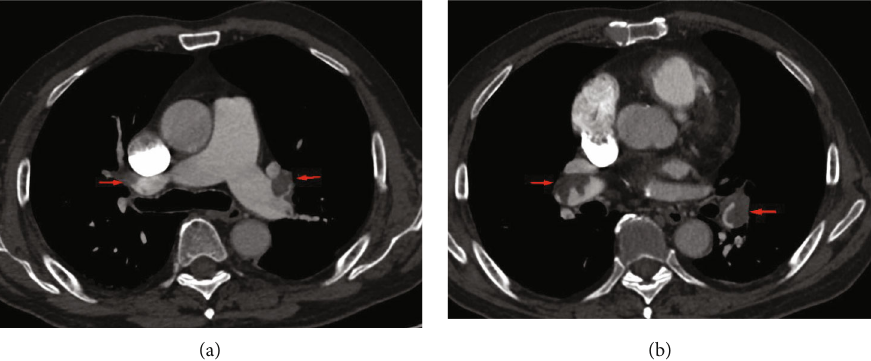
Figure 1: Computed tomography angiography (CTA) showed pulmonary embolism (yellow arrow) in the fi rst patient (a, b).